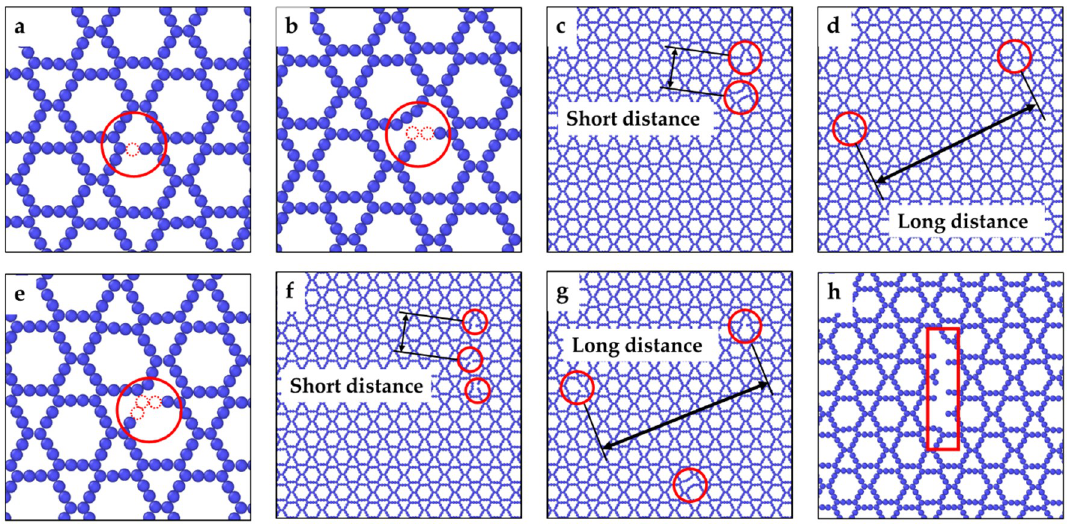
Figure 2. Various types of graphyne with defects and graphyne with a crack. ( a ) One point defect (1-1 type); ( b ) Two adjacent point defects (2-a type); ( c ) Two point defects not far apart (2-c type); ( d ) Two point defects far apart (2-f type); ( e ) Three adjacent point defects (3-a type); ( f ) Three point defects not far apart (3-c type); ( g ) Three point defects far apart (3-f type); ( h ) Graphyne with a crack.